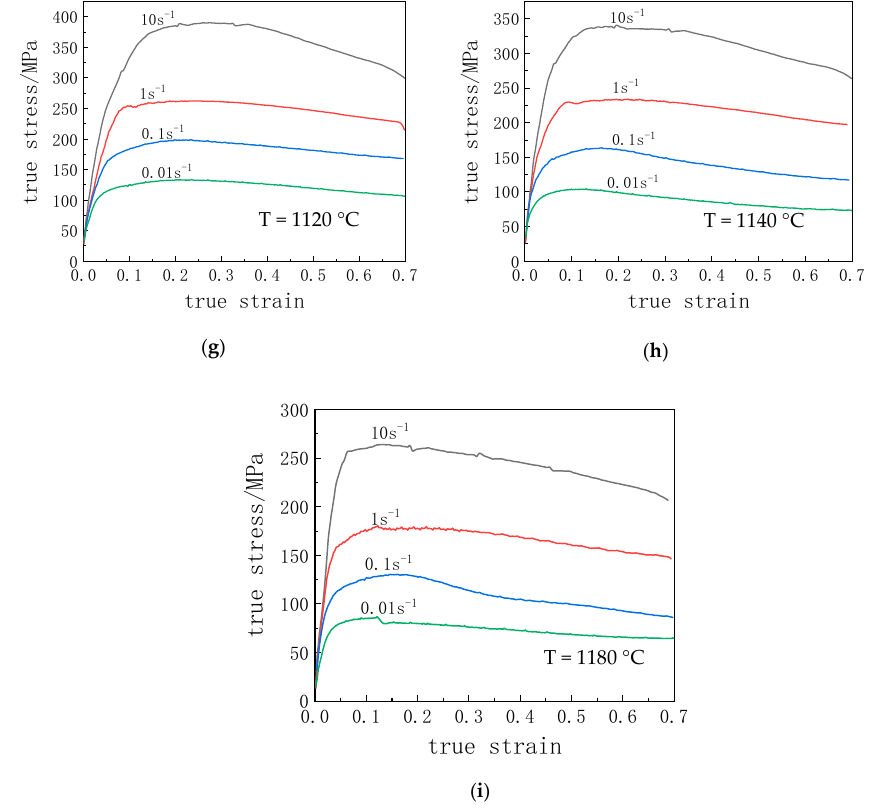
Figure 2. The true stress-strain curves of HY282 alloy at different temperatures with various strain rates: ( a ) 960 °C, ( b ) 1000 °C, ( c ) 1040 °C, ( d ) 1060 °C, ( e ) 1080 °C, ( f ) 1100 °C, ( g ) 1120 °C, ( h ) 1140 °C, (i) 1180 °C.